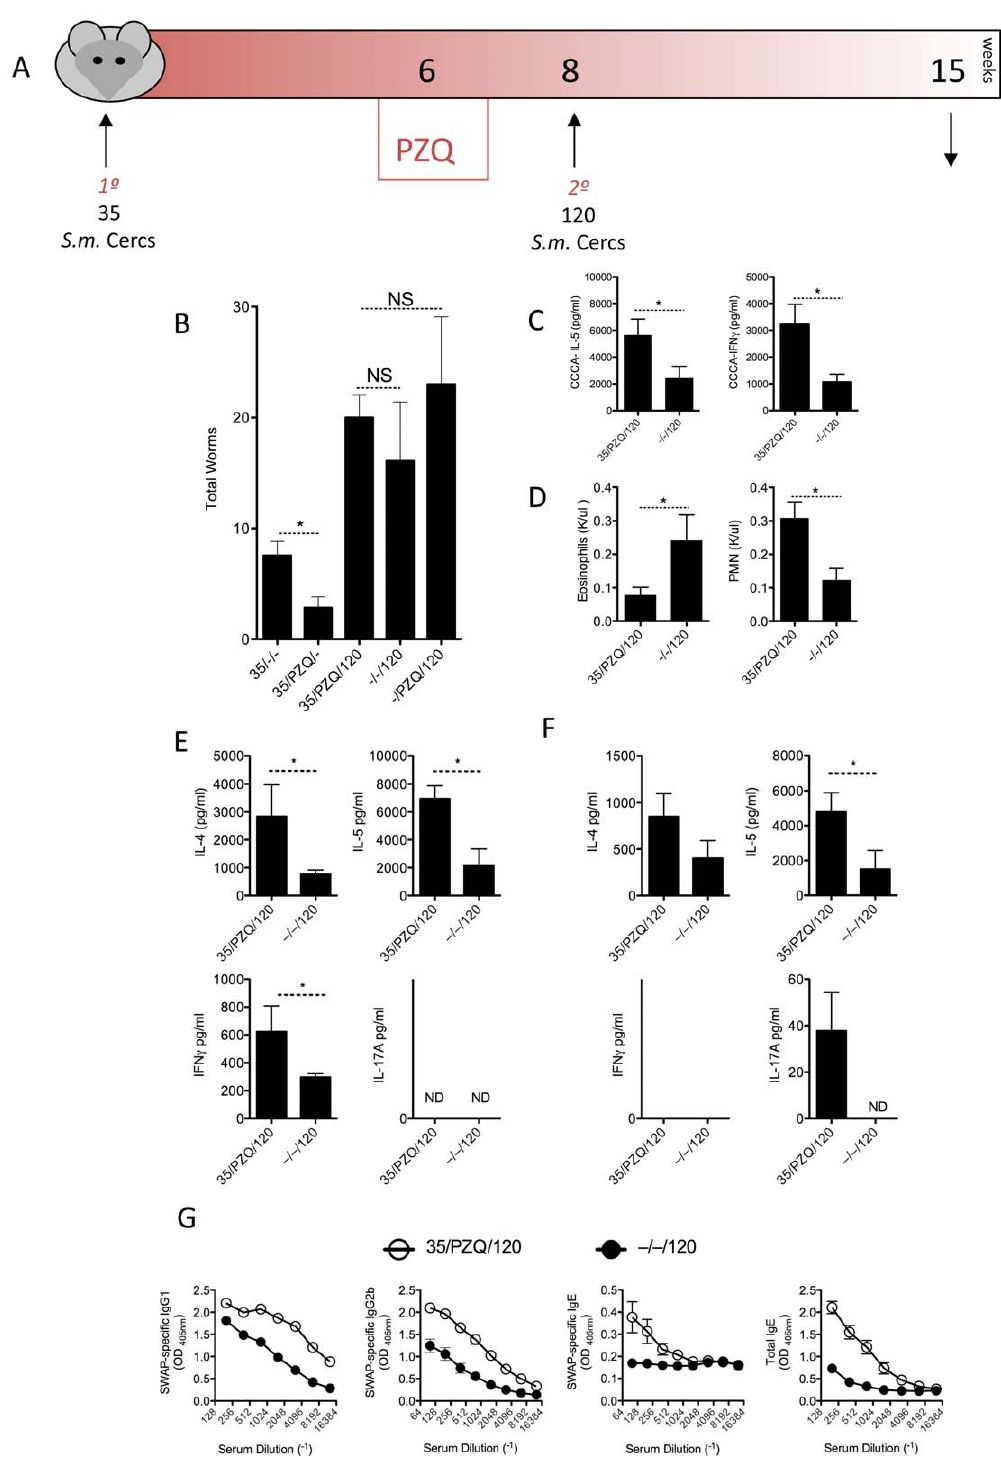
Figure 2. Comparable susceptibility to re-infection despite elevated anti-worm responses in PZQ-treated mice. C57BL/6 mice were infected with 35 cercariae (35/–/–) before treatment with 2 doses of PZQ at week 6 (35/PZQ/–). Mice were re-challenged with 120 cercariae at week 8 (35/PZQ/120), 2-weeks post PZQ treatment and killed at week 15 for analysis. 7–10 mice per group were used. Data shown are from one of 3 experiments, with mean 6 SEM. (A) Experimental model diagram. (B)Total worm numbers at week 15. (C) Serum cytokines, IL-5 and IFN c . (D) Circulating eosinophils and poly-morphonuclear cells. (E) Cytokine secretions, measured by ELISA, from adult worm antigen re-stimulated splenocytes. (F) Cytokine secretions, measured by ELISA, from adult worm antigen re-stimulated mesenteric lymph node cells. (G) Anti-worm antibody responses, measured by ELISA.